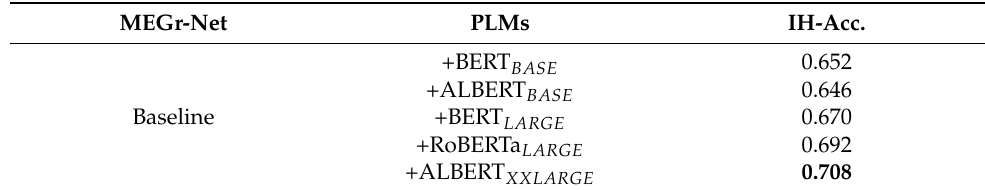
Table 5. Results on Control Group